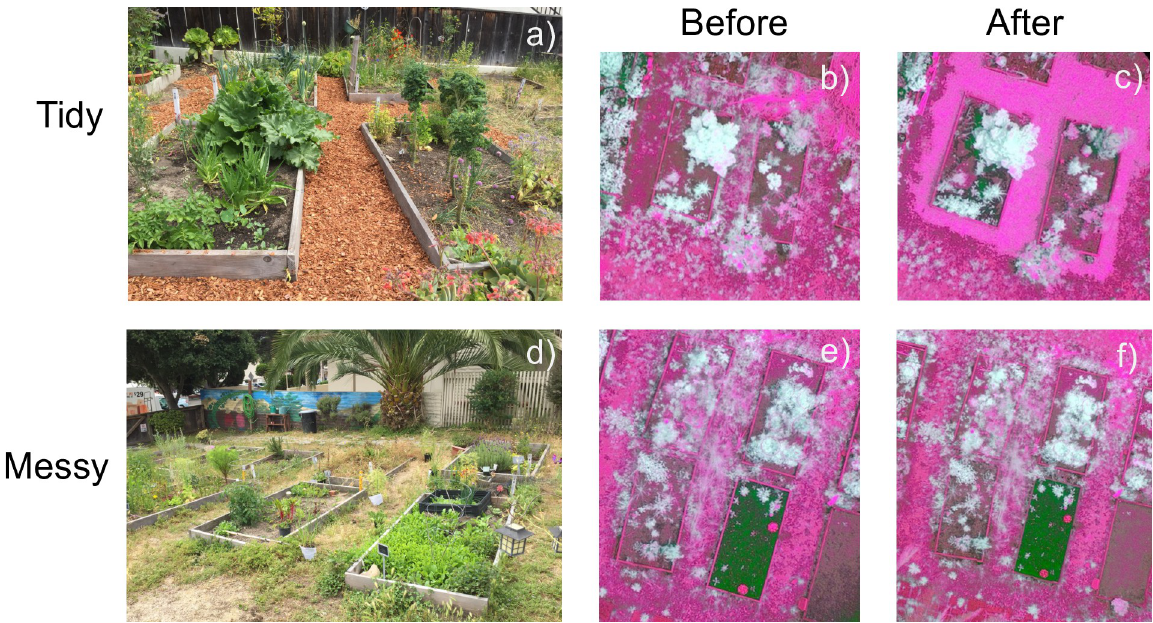
Fig 1. We implemented a ‘tidy’ and ‘messy’ manipulation in eight urban community gardens in the California Central coast. Example of the ‘tidy’ manipulation (a), with images taken before (b) and after (c) the manipulation; example of the ‘messy’ manipulation (d), with images taken before (e) and after (f) the manipulation. Images b, c, e, f are images taken from a compact commercial multirotor unmanned aerial vehicle (UAV) used to carry out autopiloted flights over the gardens for an aerial view of the manipulation. For panels b, c, e, and f, white areas are vegetation, green areas are bare soil, and pink areas are impermeable material such as wood, mulch, thatch, or